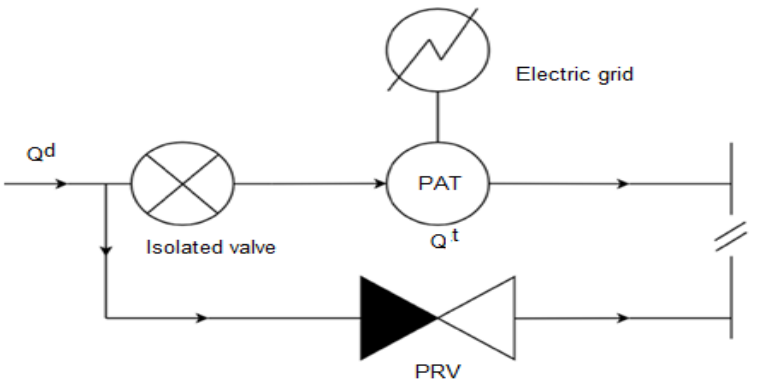
Figure 12. PAT installation scheme.